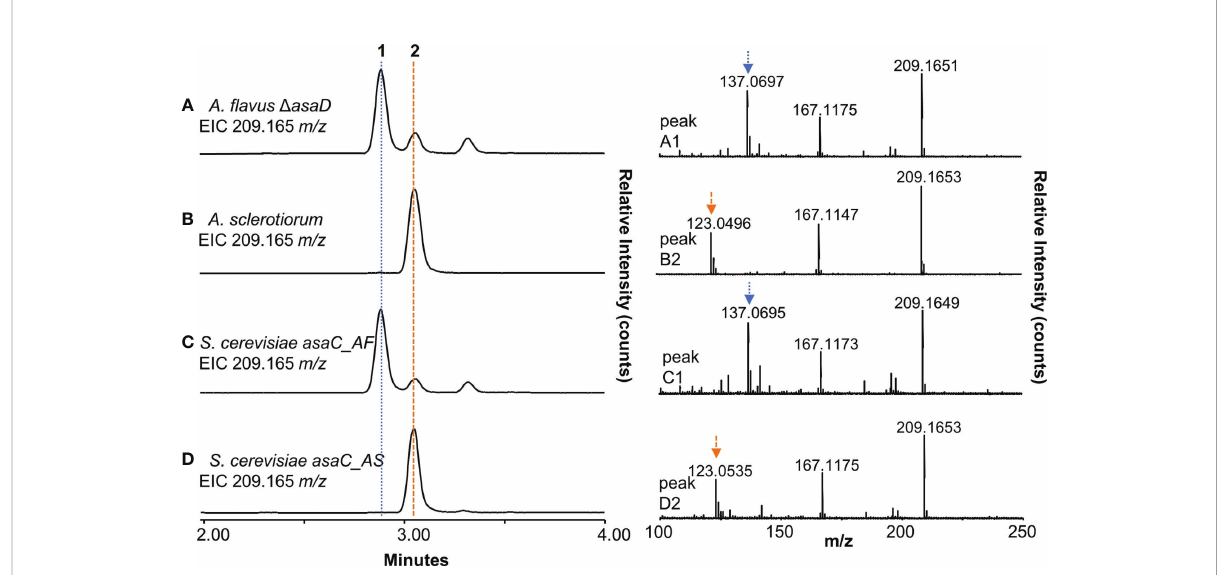
FIGURE 4 AsaC forms aspergillic acid precursor pyrazinones. (A) , left) Extracted ion chromatogram (EIC) of A. fl avus D asaD . (A) , right) High energy mass spectra of peak 1 from A. fl avus D asaD extract. (B) , left) EIC of A. sclerotiorum extract. (B) , right) High energy mass spectra of peak 2 from A. sclerotiorum extract. (C) , left) EIC of S. cerevisiae expressing asaC from A. fl avus ( asaC_AF ) extract. (C) , right) High energy mass spectra of peak 1 from S. cerevisiae asaC_AF extract. (D) , left) EIC of S. cerevisiae expressing asaC from A. sclerotiorum ( asaC_AS ) extract. (D) , right) High energy mass spectra of peak 2 from S. cerevisiae asaC_AS extract. 1 : deoxyaspergillic acid; 2 : fl